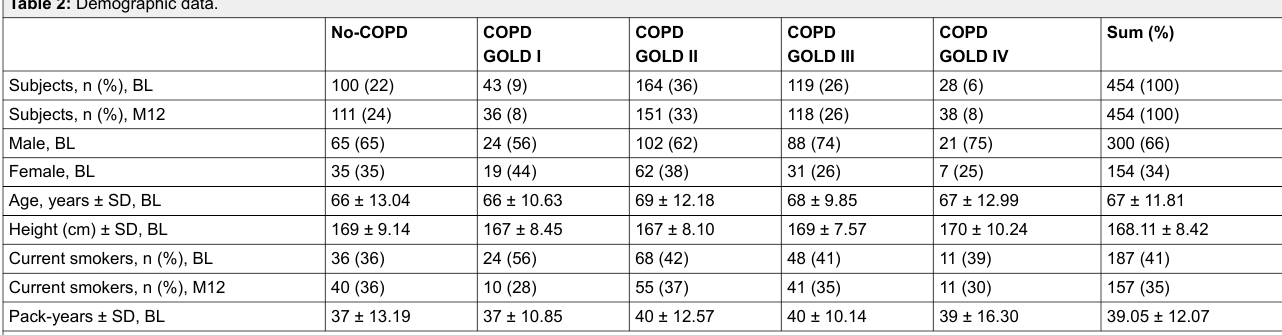
Table 2: Demographic data.